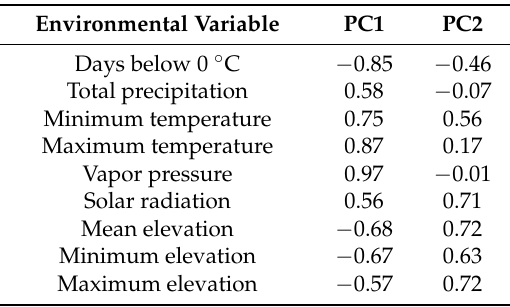
Table 2. Factor loadings of the environmental variables on Principal Component (PC) axes 1 (PC1) and 2 (PC2), expressed as correlations between a variable and a particular